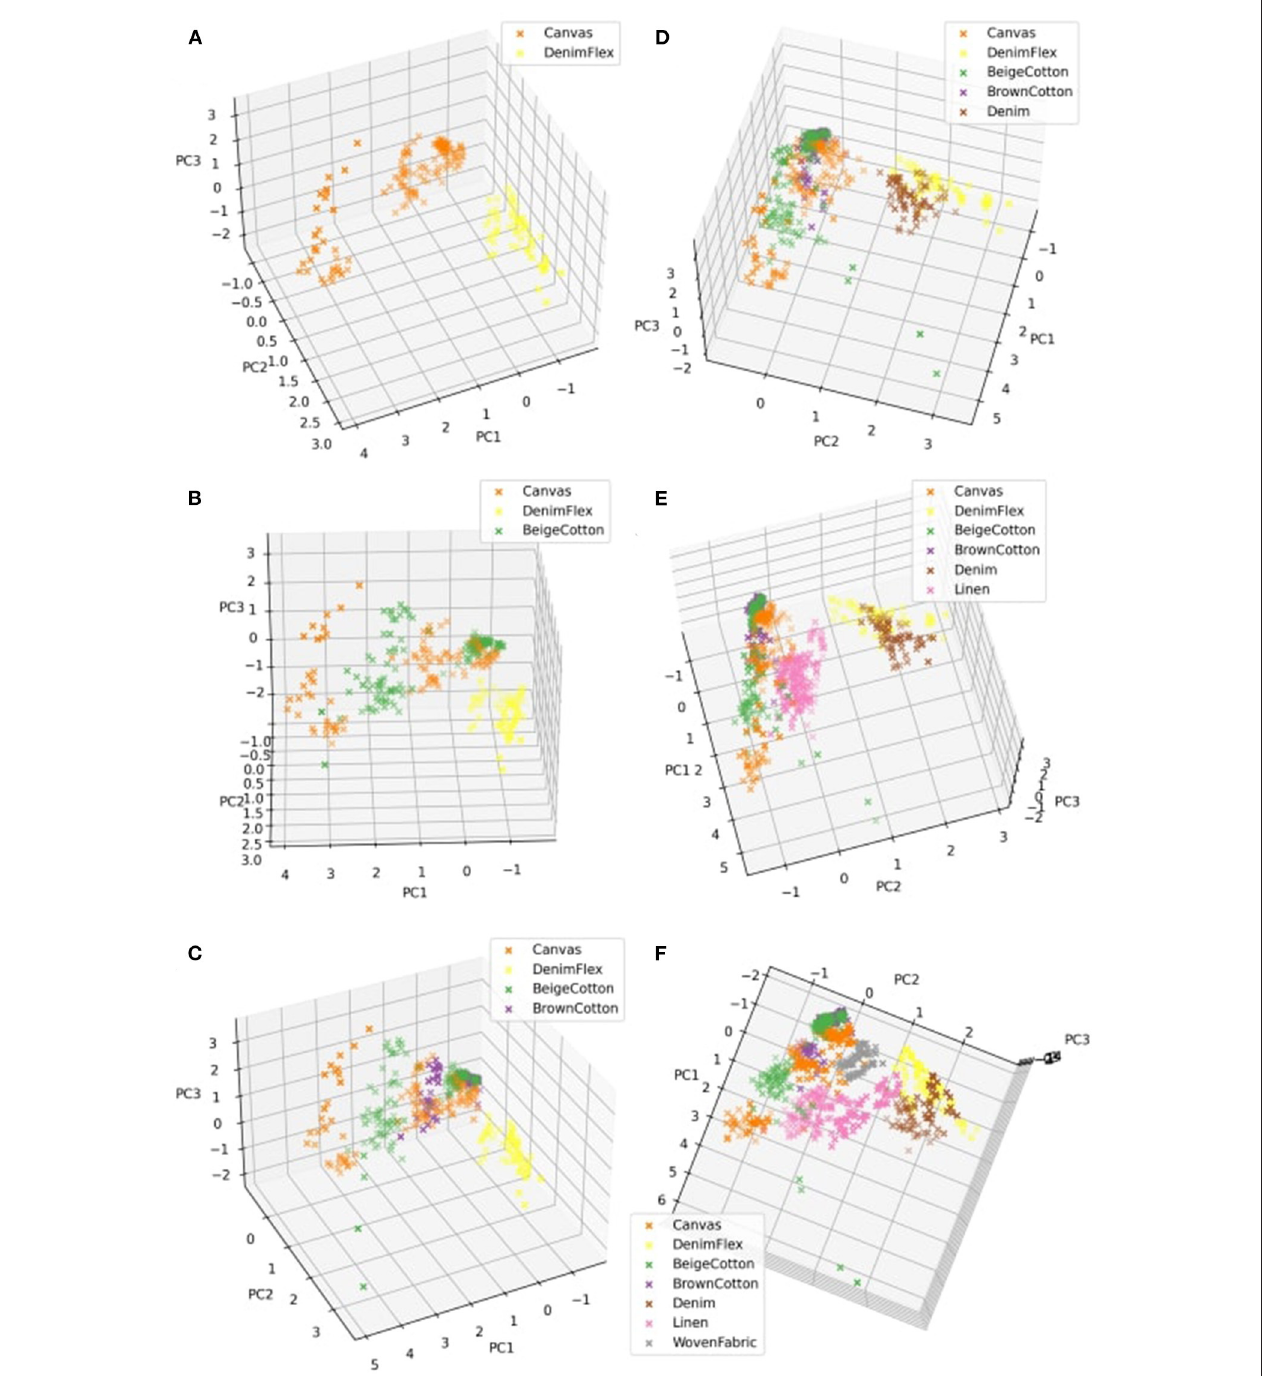
FIGURE 6 | 3D feature space of the tactile signals acquired sliding trials. (A–F) correspond to feature spaces of 2 to 7 fabrics in the process of iterative feature extraction.